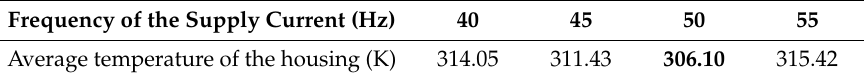
Table 2. Measured temperature values. Bold fonts indicate the nominal current frequency.